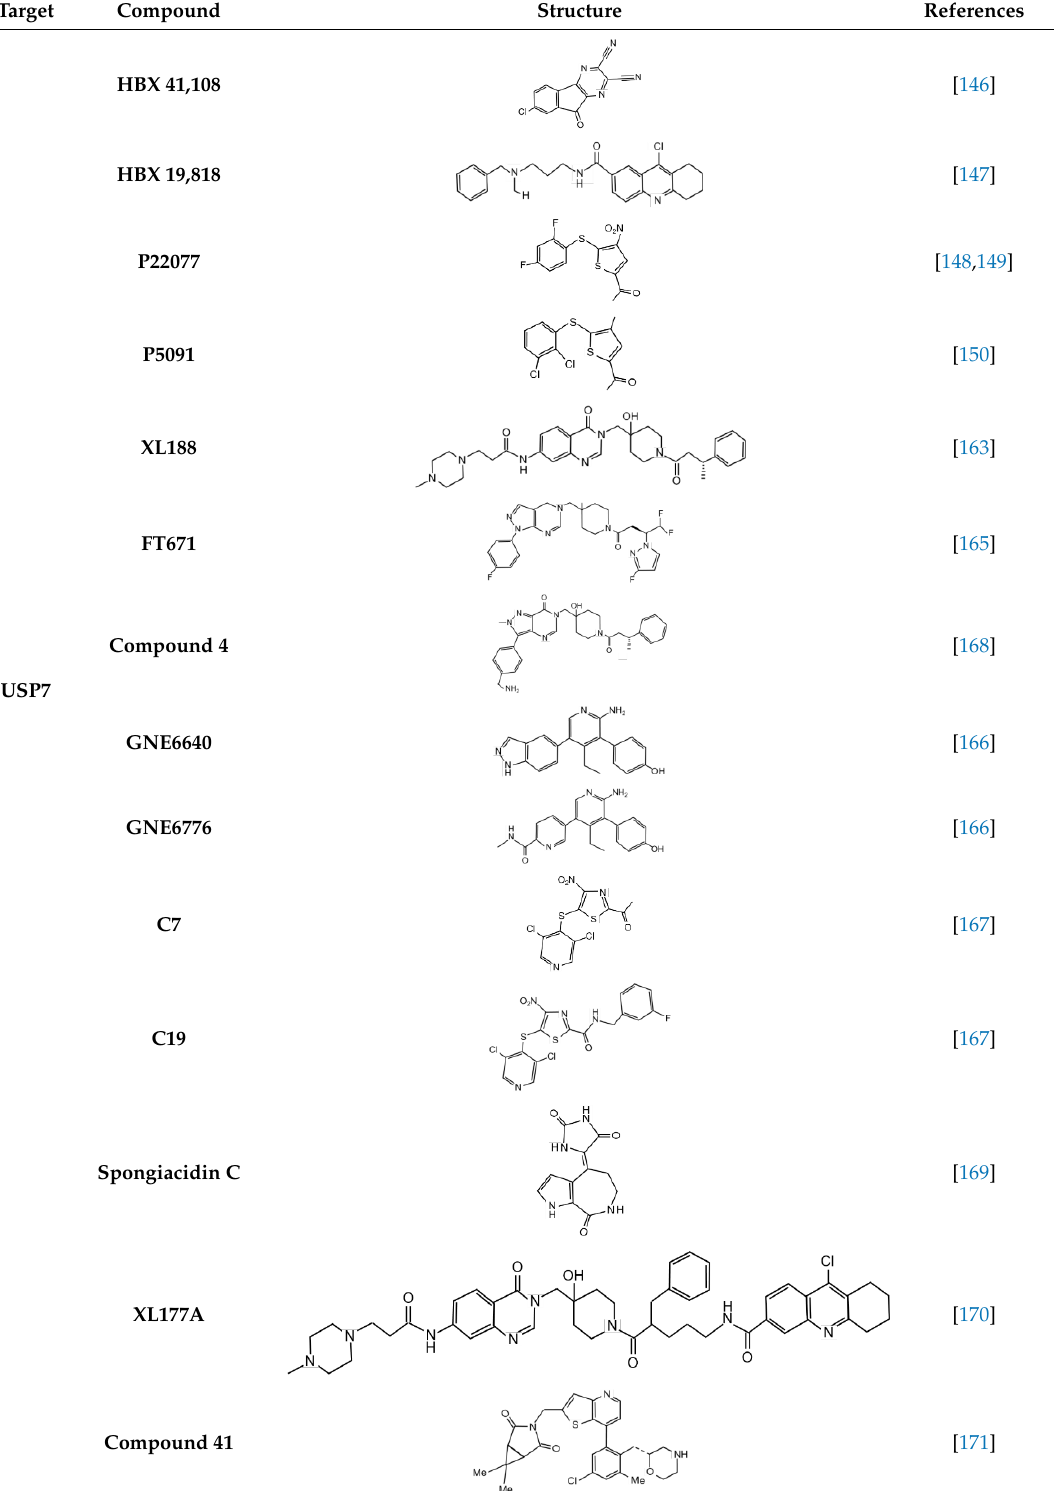
Table 2. Chemical structures of DUBs inhibitors reported in Table 1.